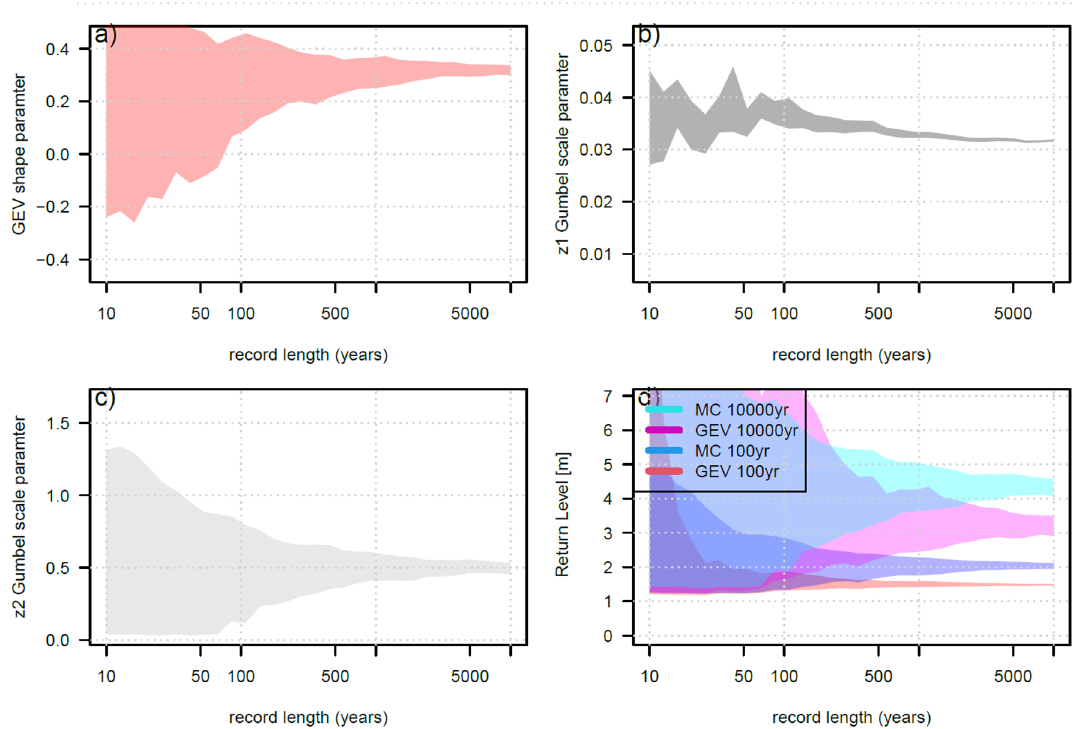
Figure 5. Stability plot for the generalised (GEV) and mixed climate (MC) EVD parameters and return levels for increasing record length (random samples) for storm tide at Lautoka, Fiji. X-axis on a log scale. 90% confidence bounds calculated from 100 Monte Carlo simulations for each record